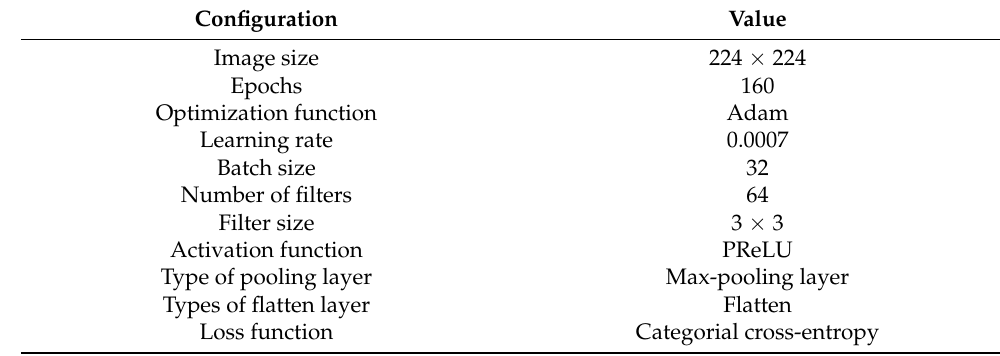
Table 5. Configuration of the proposed architecture after ablation